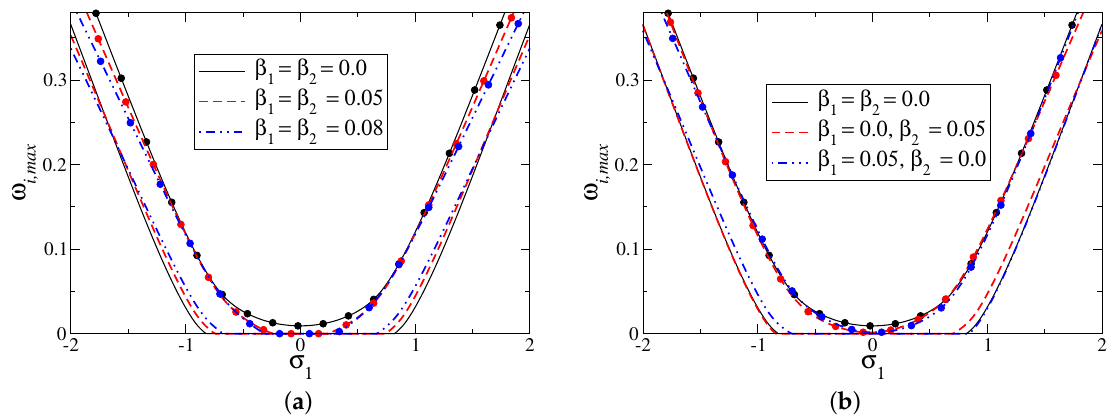
Figure 9. Maximum growth rate ( ω i , max ) as a function of σ 1 for Re = 1000 and σ 2 = 0.0, 0.2: ( a ) with symmetric slip ( β 1 = β 2 ); and ( b ) with non-symmetric slip ( β 1 (cid:54) = β 2 ). Curves with symbols are for σ 2 = 0.2.